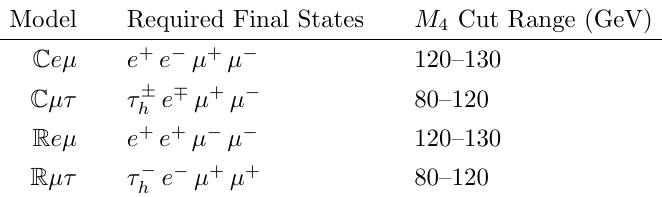
Table 4 . The four pure o(cid:11)-diagonal, single-coupling models considered in this section. The